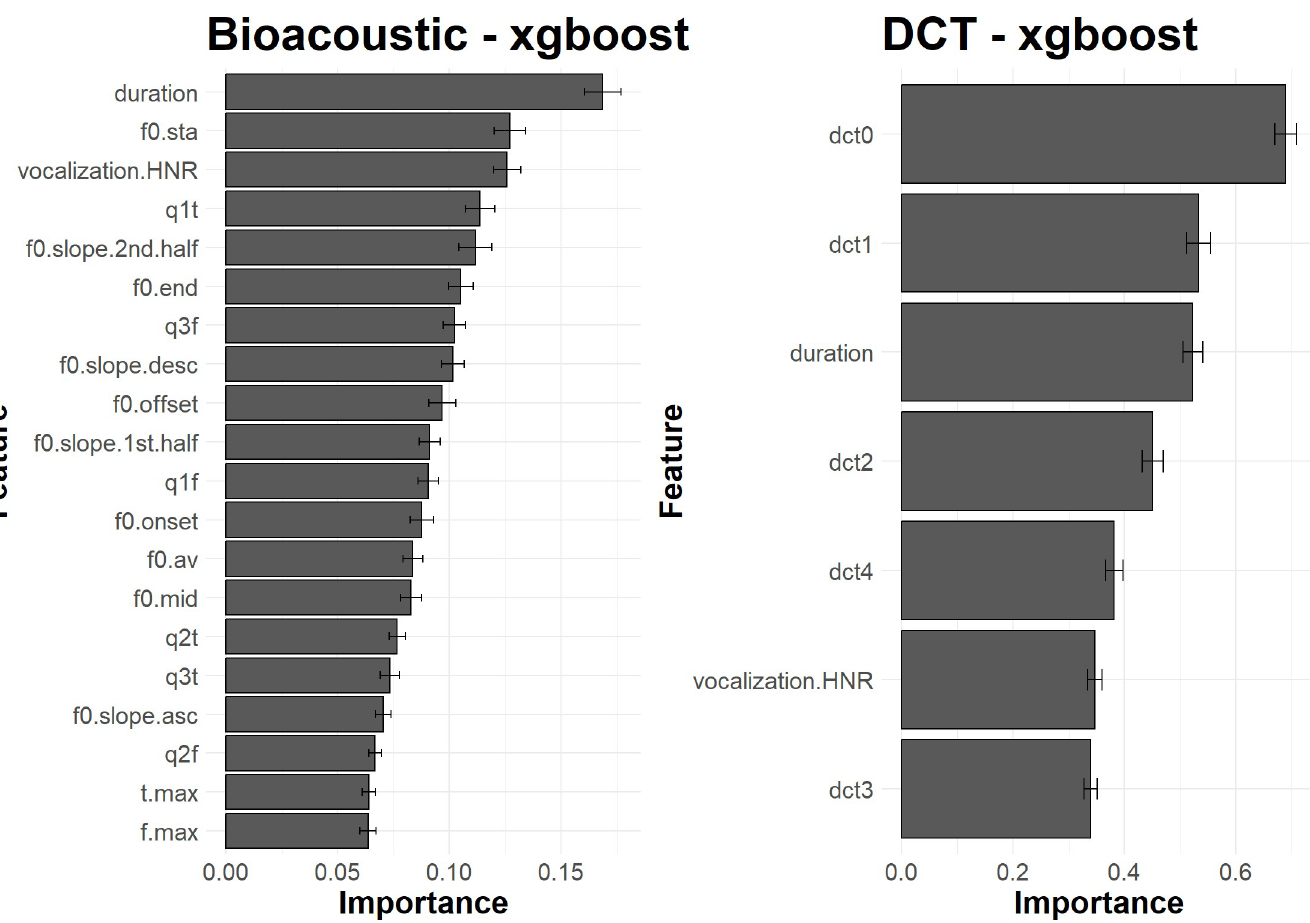
Fig 11. Average importance of acoustic features, for 100 iterations of the evaluation process, when classifying individual signatures with xgboost. Left . Features of the Bioacoustic set. Right . Features of the DCT set. The bar plots illustrate the relative influence of each acoustic feature on the classification performance. The error bars report the standard deviation of the measure of importance for the 100 iterations of the evaluation